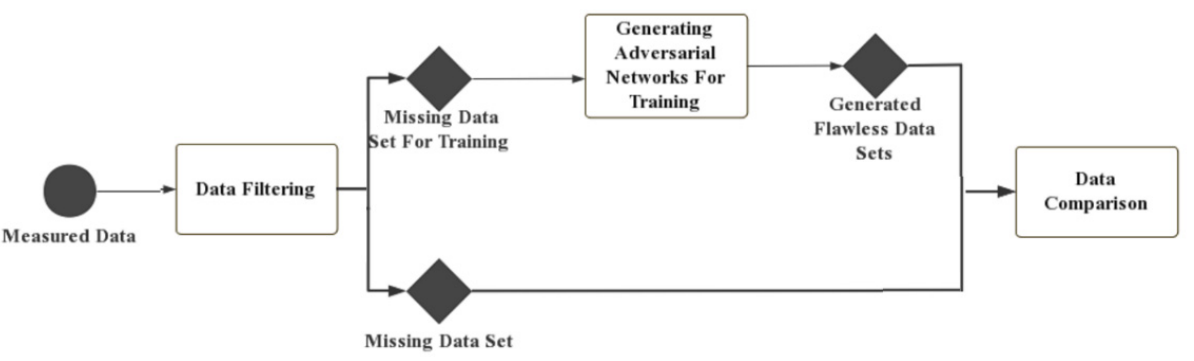
Figure 4. The experimental procedure.